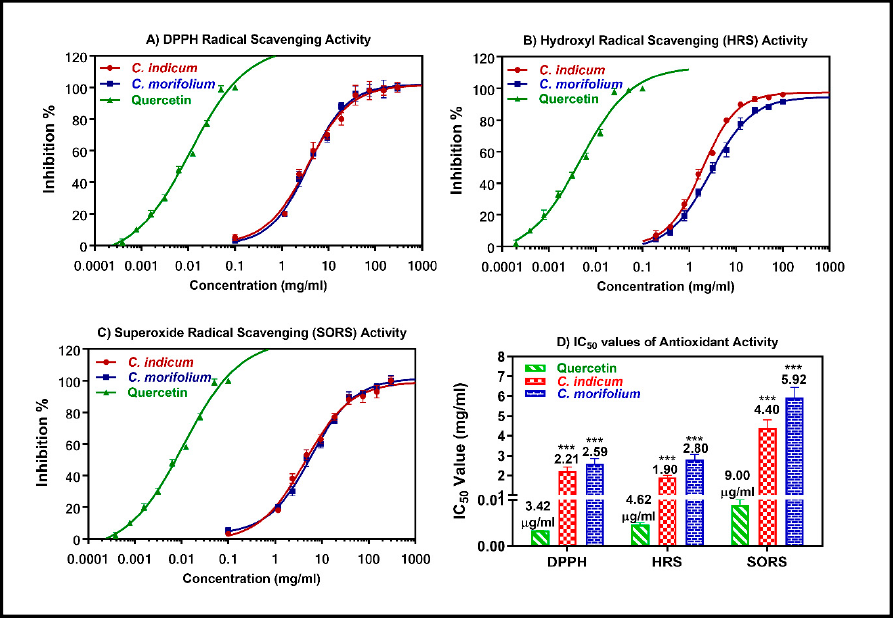
Figure 8. Antioxidant activities of the essential oils obtained from C. indicum and C. morifolium flower heads versus quercetin as a reference drug in DPPH ( A ), hydroxyl radical scavenging (HRS) ( B ), and superoxide radical scavenging (SORS) ( C ) assays. The means with different Stars are significantly different ( p < 0.05).